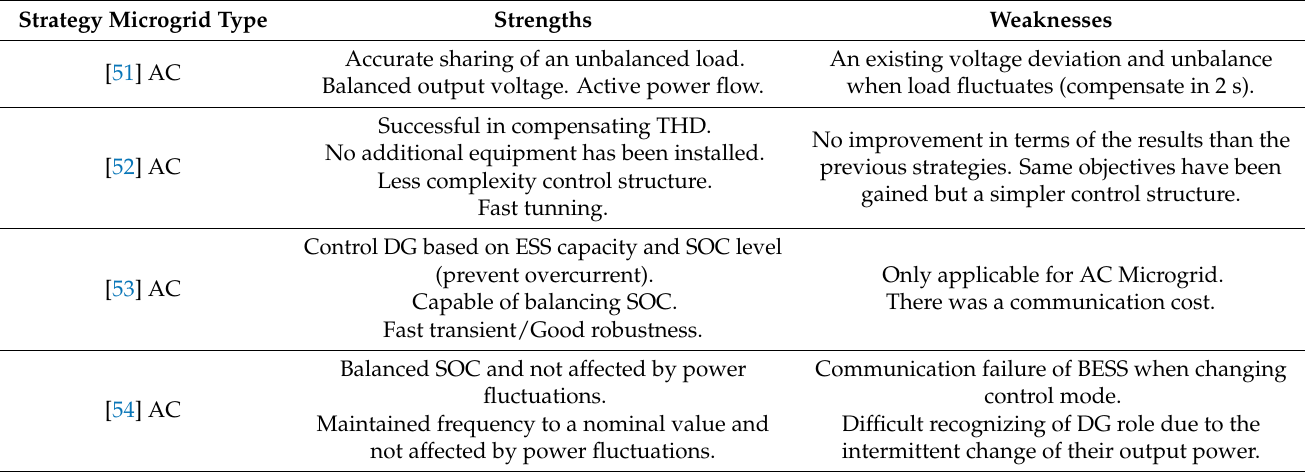
Table 2. Summary of centralized control